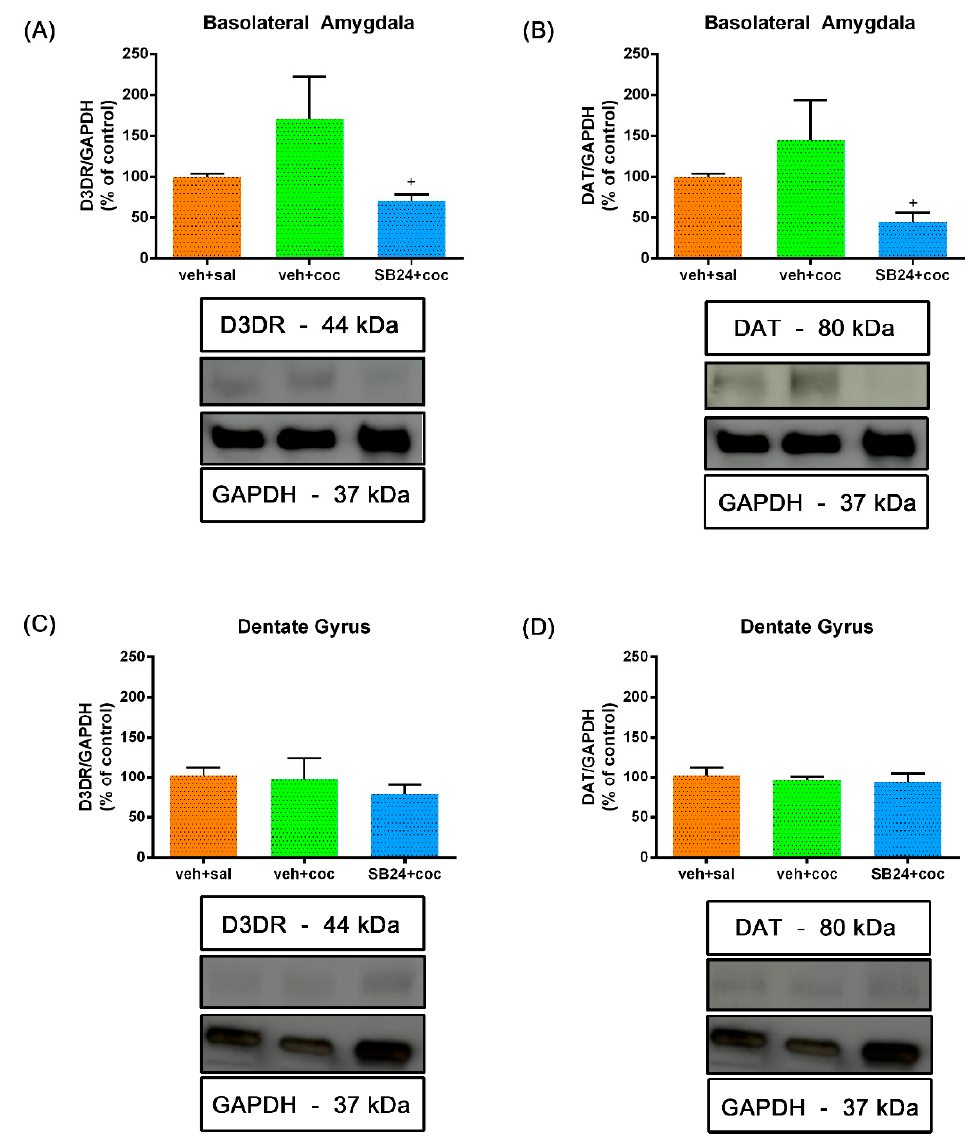
Figure 3. Semiquantitative analysis and representative immunoblot of dopamine type 3 receptor (D3DR) and dopamine transporter (DAT) in the basolateral amygdala (( A , B ), respectively) and dentate gyrus (( C , D ), respectively). Mice were conditioned to cocaine and after 60 days of abstinence they were administered with saline (veh+sal; controls), with a dose of cocaine prime (veh+coc) or with an injection of the D3DR antagonist SB-277011-A (24 mg/kg i.p.) prior to the cocaine priming (SB24+coc). A preference test was conducted giving the animals free access to both compartments of the CPP apparatus for 15 min. Mice were sacrificed immediately after the reinst test. + p < 0.05 vs. veh+coc. No significant changes in D3DR or DAT levels were found between groups in the dentate gyrus. Each bar corresponds to mean ± standard error of the mean (n = 5–8 per group).